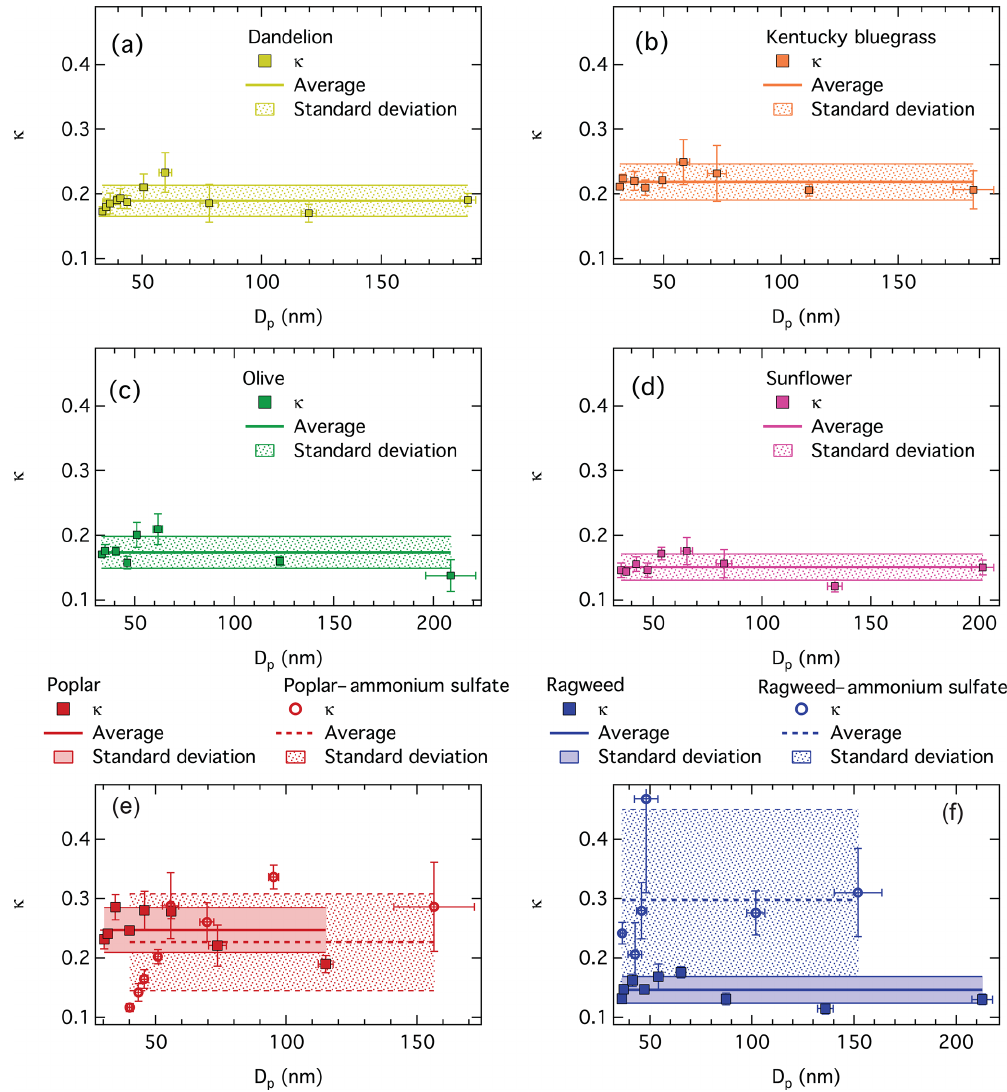
Figure 3. Hygroscopicity values κ from CCN activity measured by SMCA for all particle compositions. Panels (a) – (d) for pure dandelion, Kentucky bluegrass, olive, and sunflower pollenkitt. Panels (e) and (f) for pure poplar and ragweed pollenkitt, respectively, and their mixtures with ammonium sulfate. Error bars are standard deviations from the D p , 50 calculated from the SMCA data inversion and standard deviations of the κ values inverted from pairs of D p , 50 and SS c